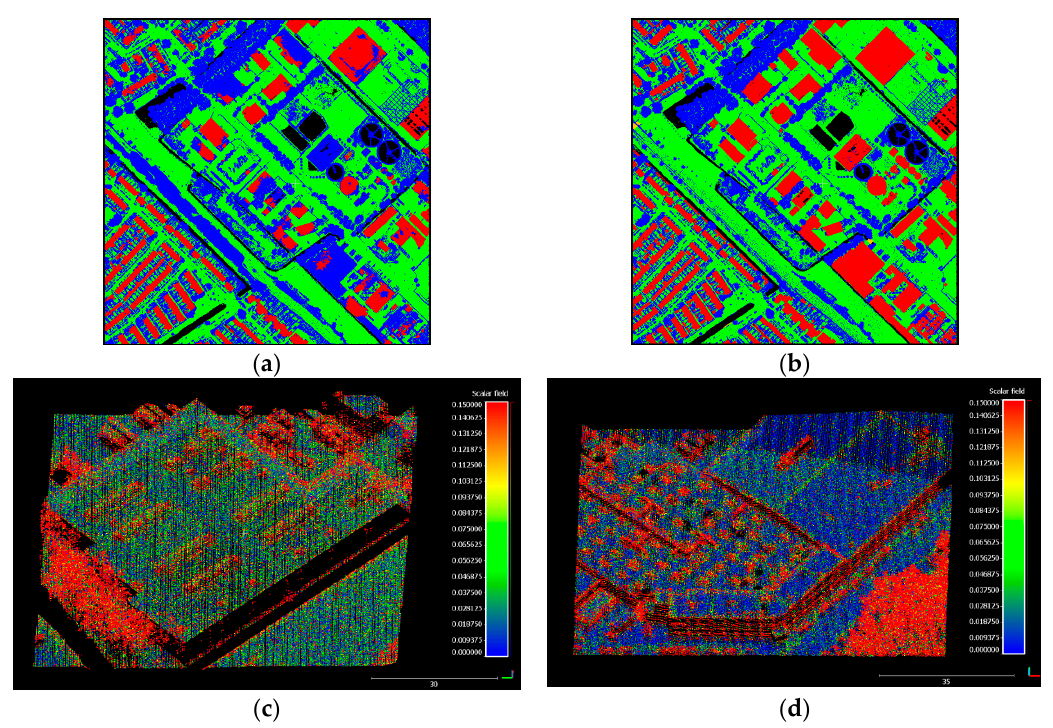
Figure 18. Error on FCN result due to noise in sample TS5: ( a ) prediction; ( b ) reference; ( c ) noise in one building in TS5; ( d ) noise in one building in the training set. Note that noise in ( c ) is higher than in ( d ).